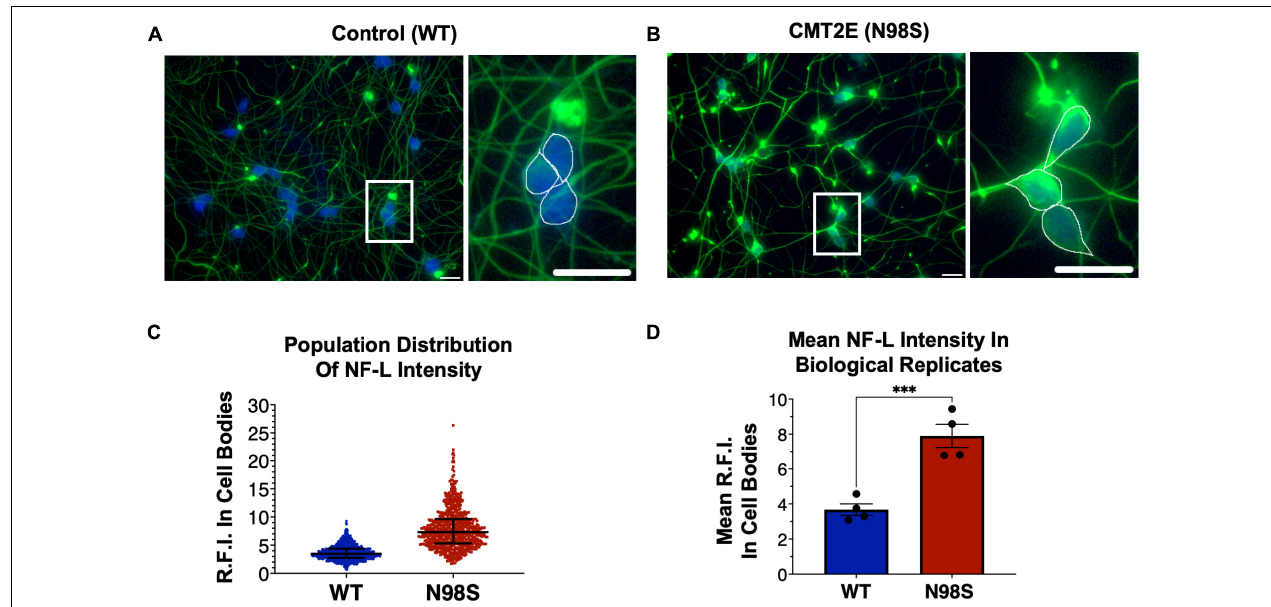
FIGURE 2 | Pathologic accumulation of NF-L protein in the cell body of NEFL -N98S motor neurons. (A,B) Representative images of day-7 WT (A) and N98S (B) i 3 LMNs stained with anti-NF-L (green) and anti-HB9 (blue) antibodies. Boxed regions are shown in larger scale to the right of each image with manual cell body segmentation superimposed. Scale bars = 25 µ m. (C) Distribution of NF-L fluorescence intensity in individual HB9+ cell bodies after manual segmentation. Individual data points are shown with horizontal lines representing median and interquartile range. (D) Quantification of mean NF-L fluorescence intensity from four biological replicates per cell line, demonstrating significantly increased intensity in N98S neurons. Points represent mean of > 160 neurons quantified in each sample population, bars represent mean of all replicates ± S.E.M., *** p < 0.001 by t